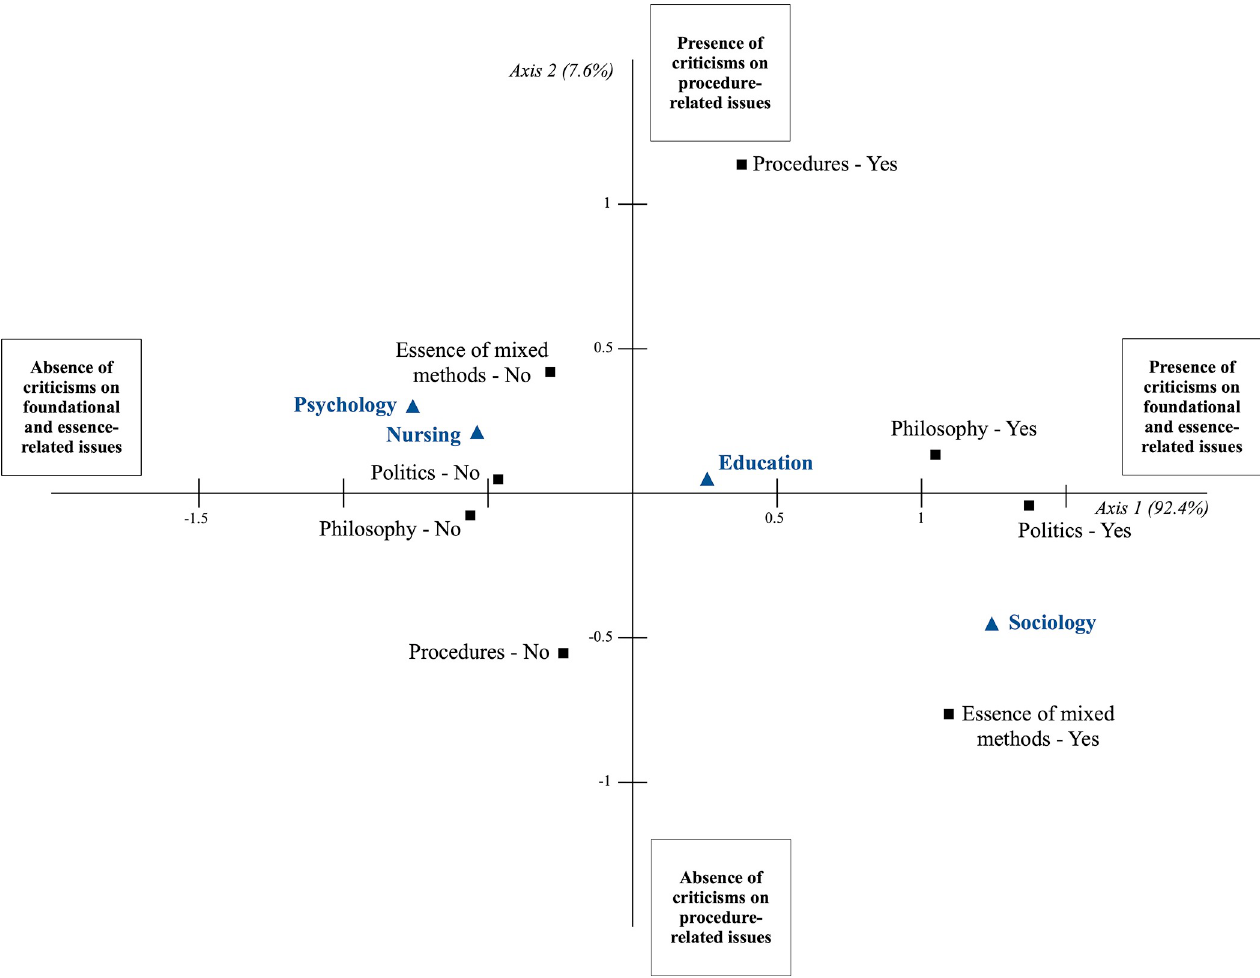
Fig 1. Multiple correspondence analysis map of the criticisms of the mixed methods field by study participants: Active categories (black squares), discipline as supplementary variable (blue triangles). Note: The Yes label indicates that the criticism was mentioned, while the No label indicates that the criticism was not